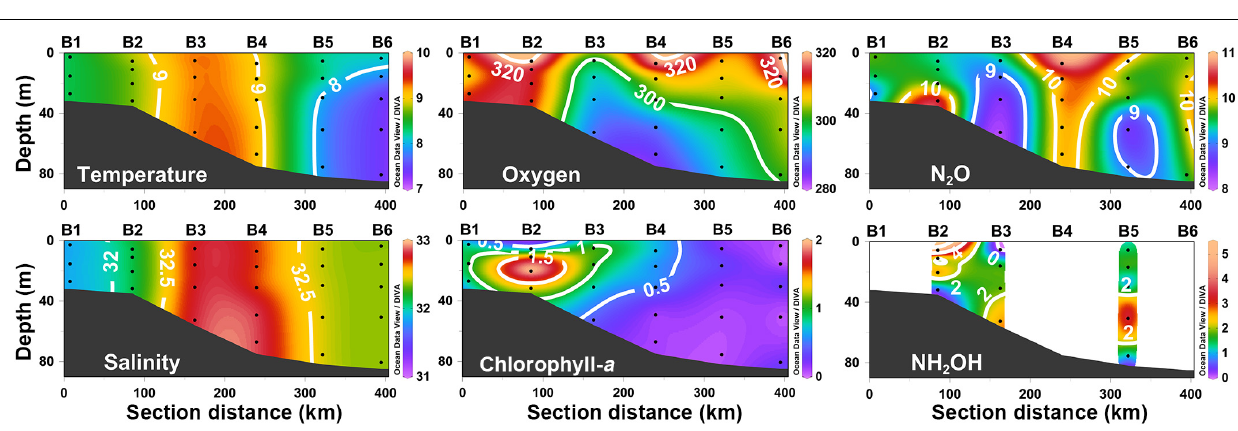
FIGURE 3 | The vertical distributions of temperature ( ◦ C), salinity (psu), dissolved oxygen ( µ mol L − 1 ), chlorophyll- a ( µ g L − 1 ), N 2 O (nmol L − 1 ), and NH 2 OH (nmol L − 1 ) along section